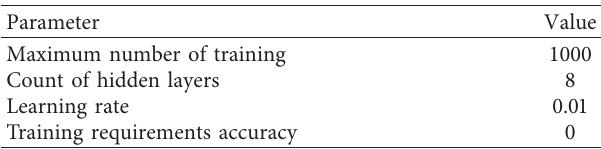
Table 1: Parameter